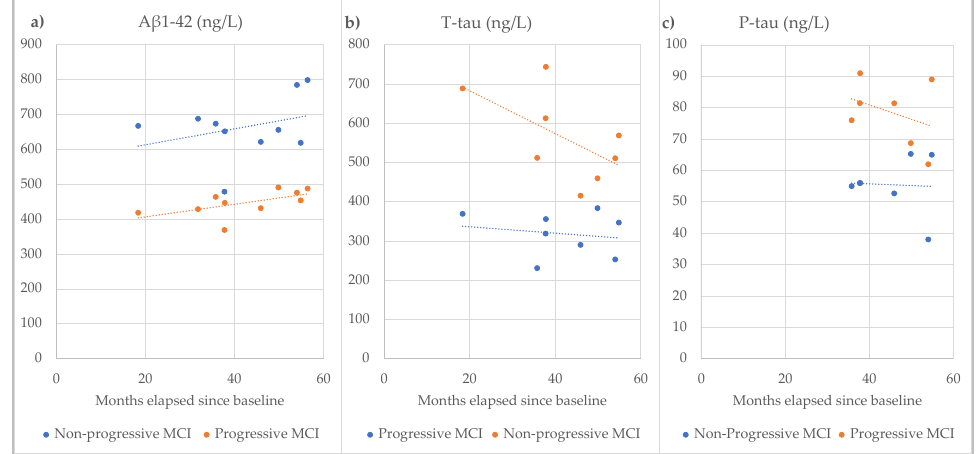
Figure 14. Showing the relationship between analyte value and months elapsed since baseline for ( a ) Amyloid, ( b ) T-tau, and ( c ) P-tau from the subset of studies in this systematic review that included follow-up duration [34,36,37,46,47,53,54,56 – 58].